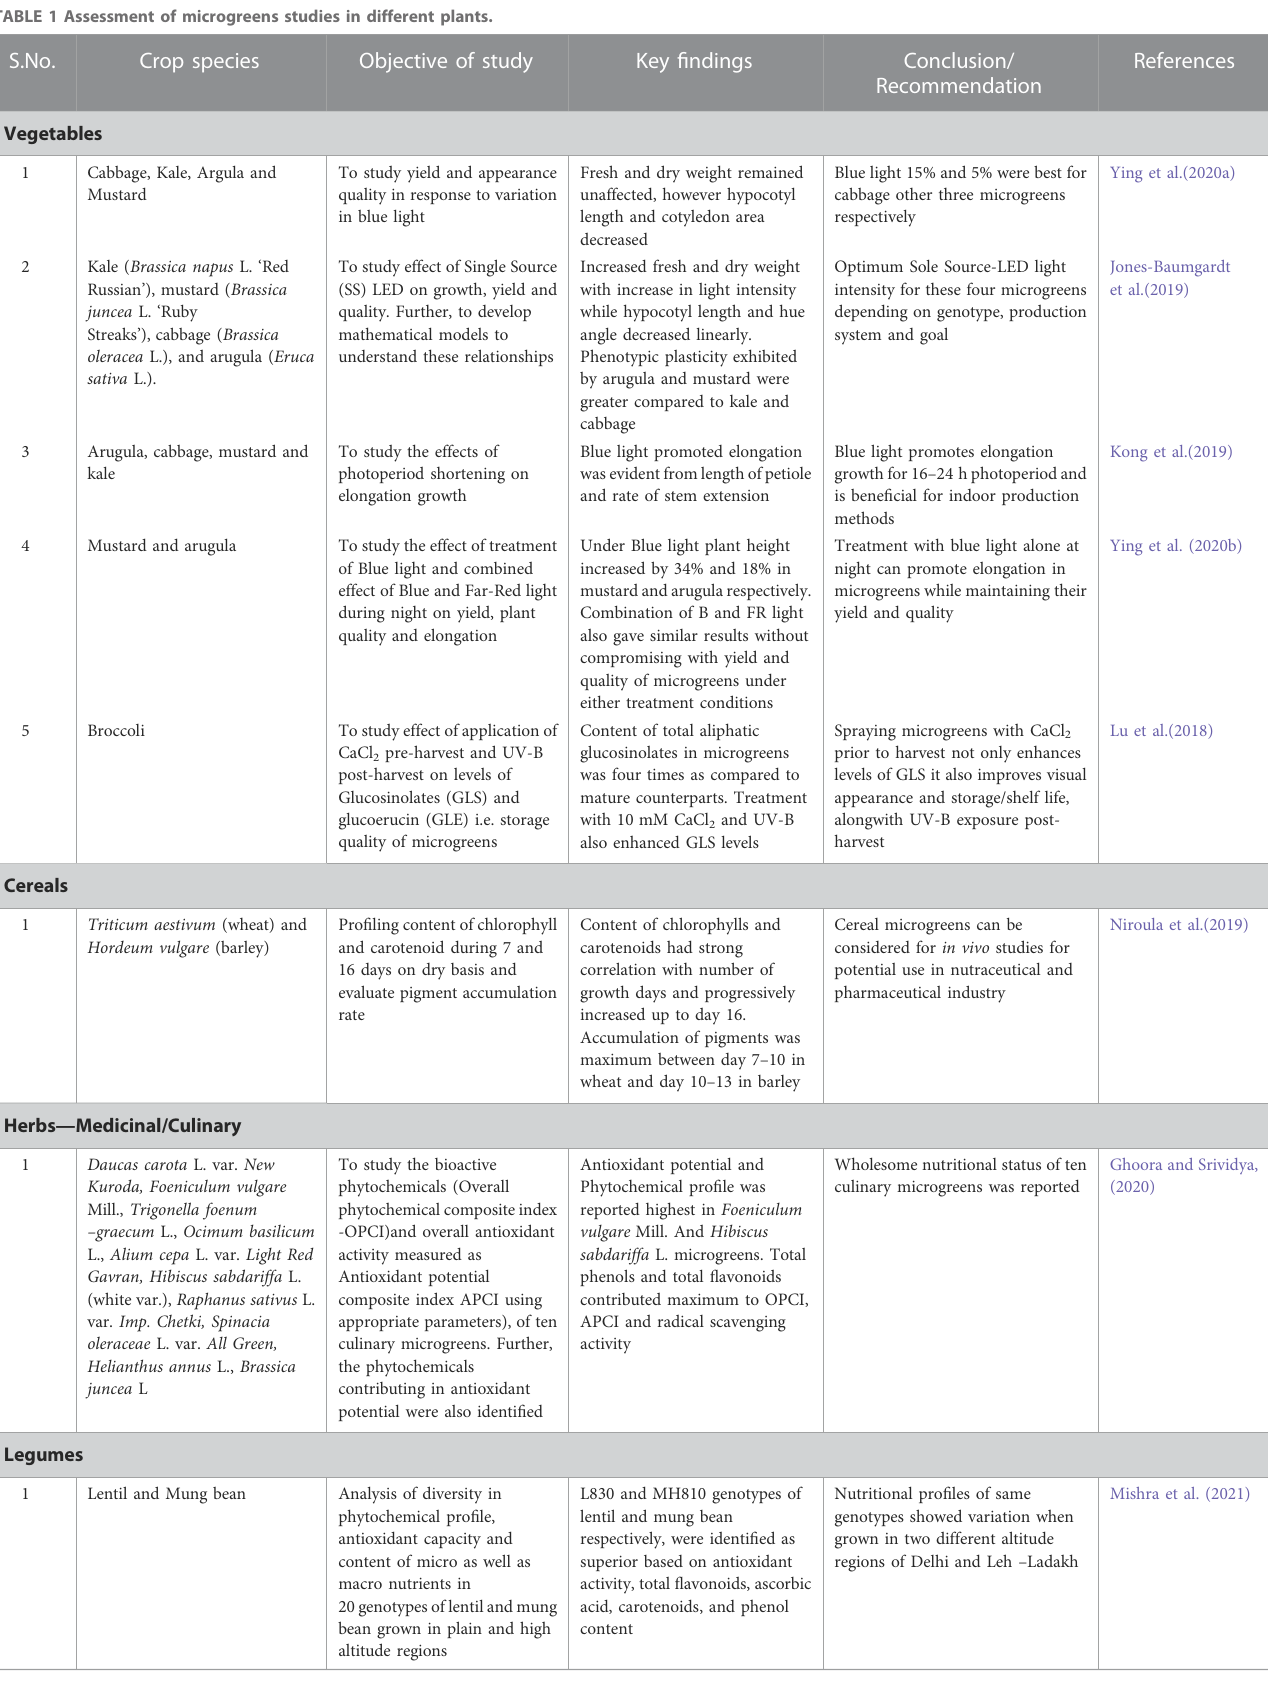
TABLE 1 Assessment of microgreens studies in different plants.